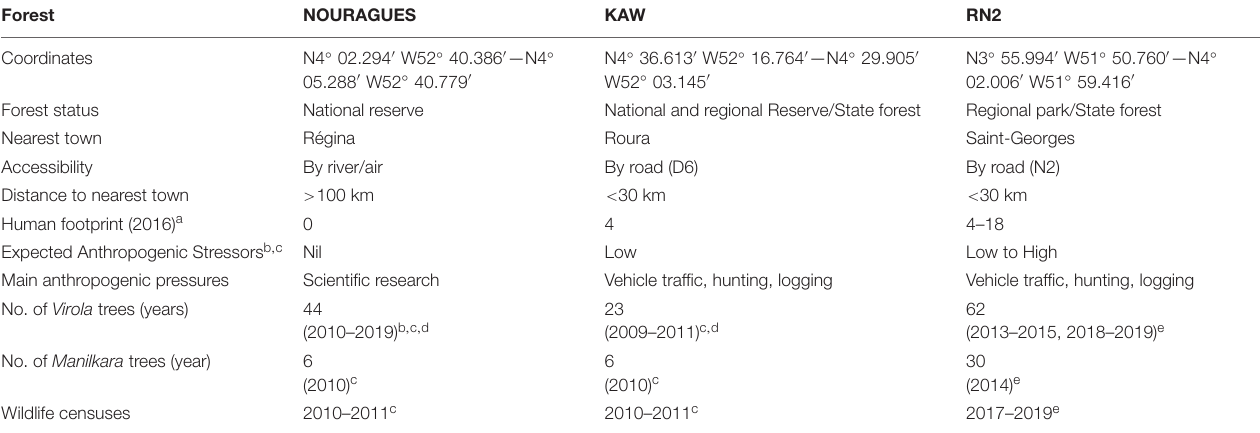
TABLE 1 | Study sites in French Guiana, with hypothesized increasing intensities of anthropogenic disturbance (NOURAGUES, Nouragues Field Station; KAW, Montagne de Kaw; RN2, Road “Nationale 2”). Forest